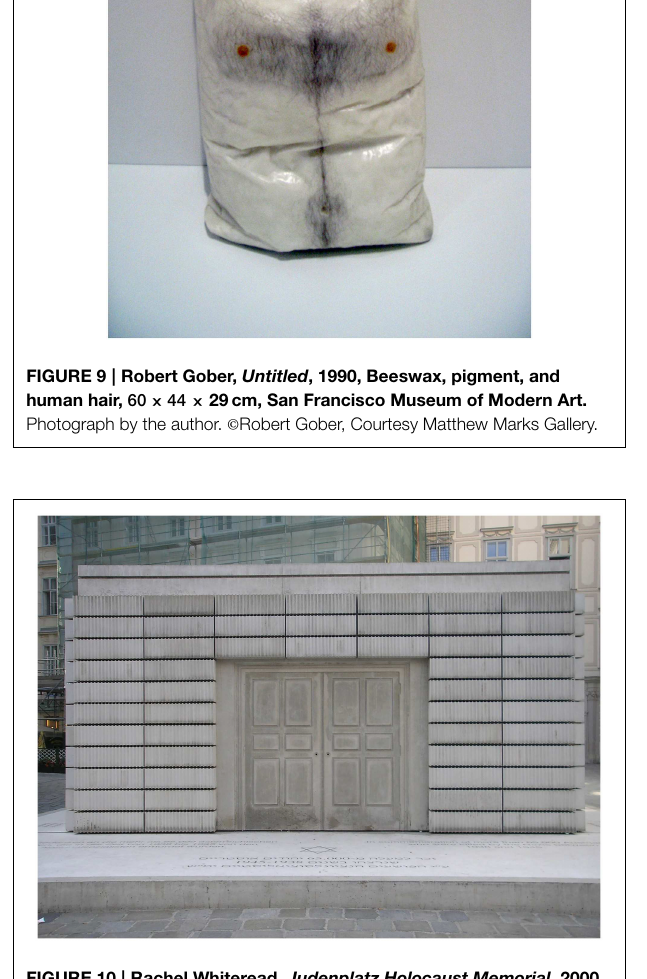
FIGURE 8 | René Magritte, The Treachery of Images, 1928/29, Oil on canvas, 62 × 81 cm, Los Angeles, County Museum. © ADAGP, Paris and DACS, London 2015.